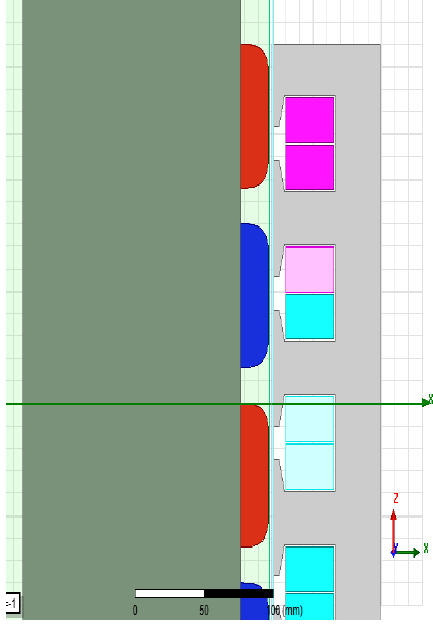
Figure 9. PM model optimized with the level-set method.